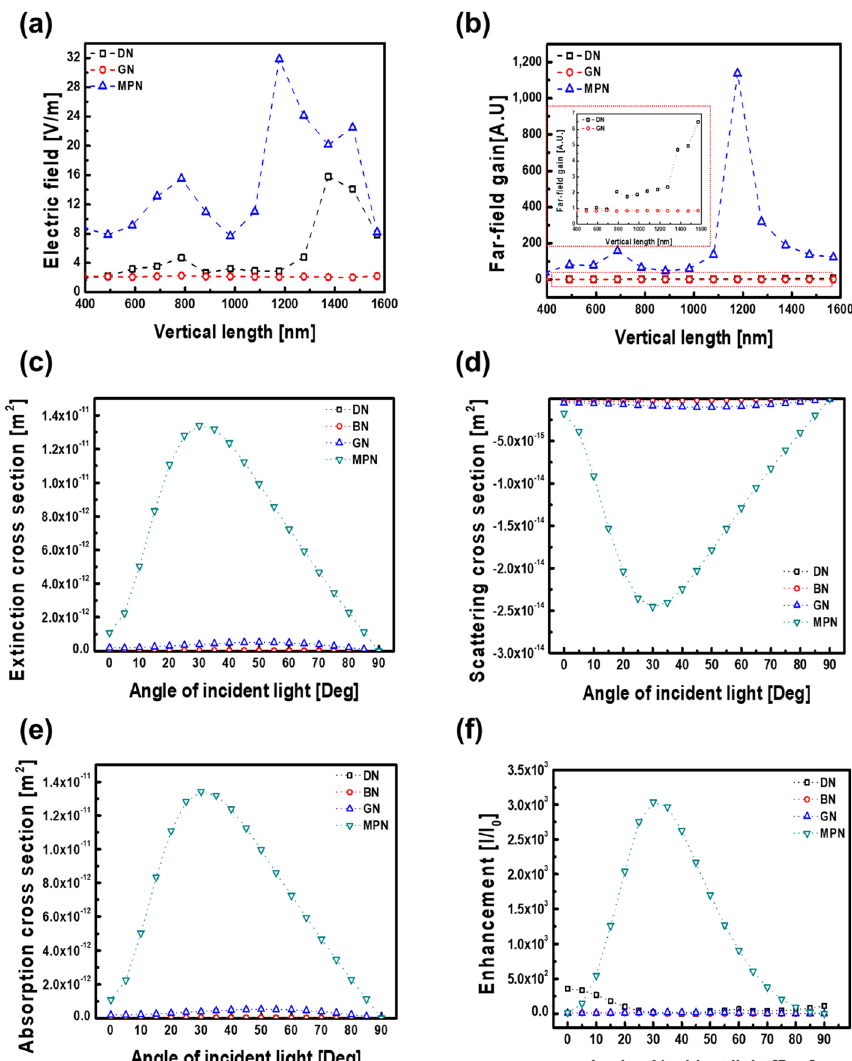
Fig. 3 MPN simulation data. a Simulation of the electric field in the output domain depending on the vertical lengths of the MPN, GN, and DN. b Simulation of the far-field gain depending on the vertical lengths of the MPN, GN, and DN. c, d, e Simulation of the extinction, scattering, and absorption cross-sections of the MPN, GN, and DN depending on the angle of incident light. f Graph of enhancement achieved with the MPN, GN, and